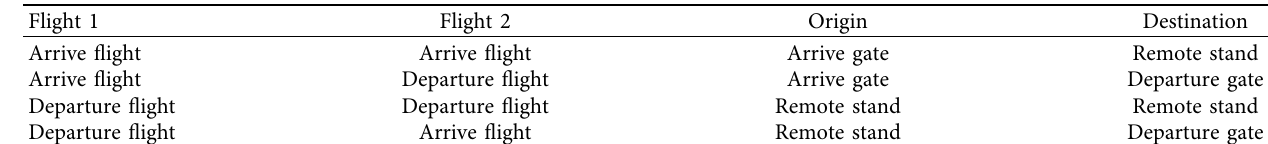
Figure 1: Spatial layout of the airport flight area. Table 1: OD point conversion of continuous